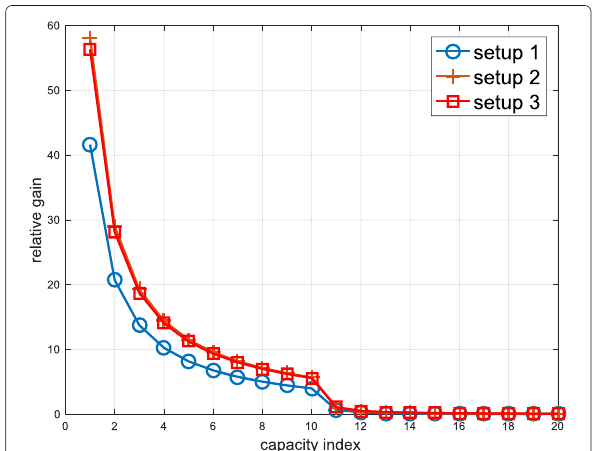
Fig. 4 Relative performance gain versus the index of I n ,max